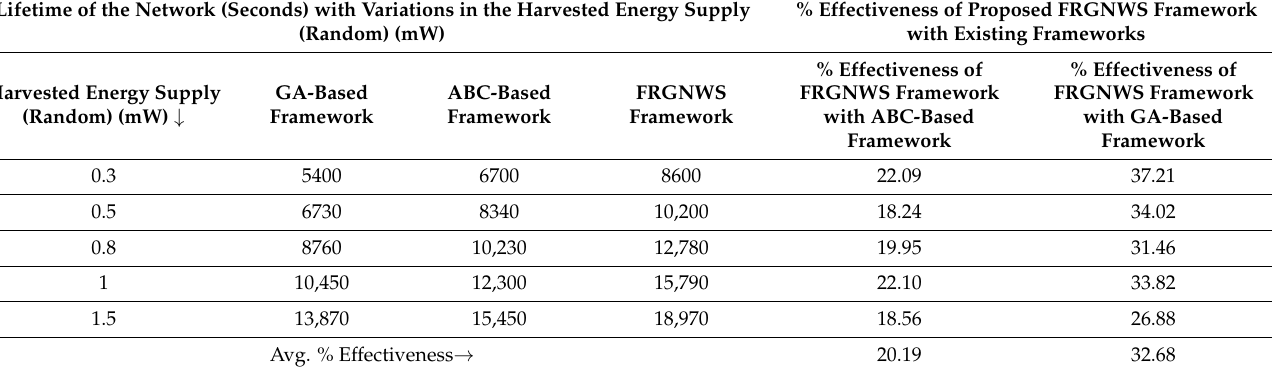
Table 12. The avg. % effectiveness of the proposed novel framework for the lifetime of the network metric with variations in the harvested energy supply